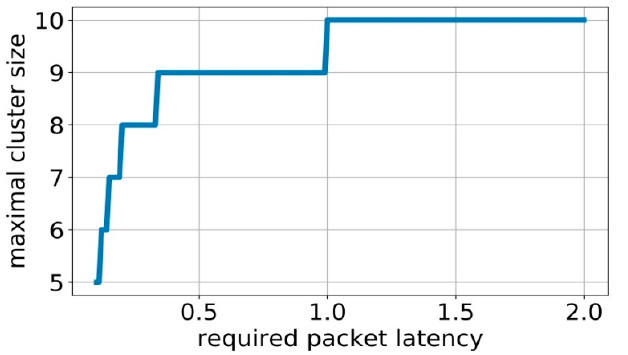
Figure 6. Packet latency versus cluster size reduction: ( a ) the impact of the initial cluster size; ( b ) the impact of cluster head performance; ( c ) the impact of traffic intensity from one cluster node; and ( d ) a 3D plot of the relative difference.